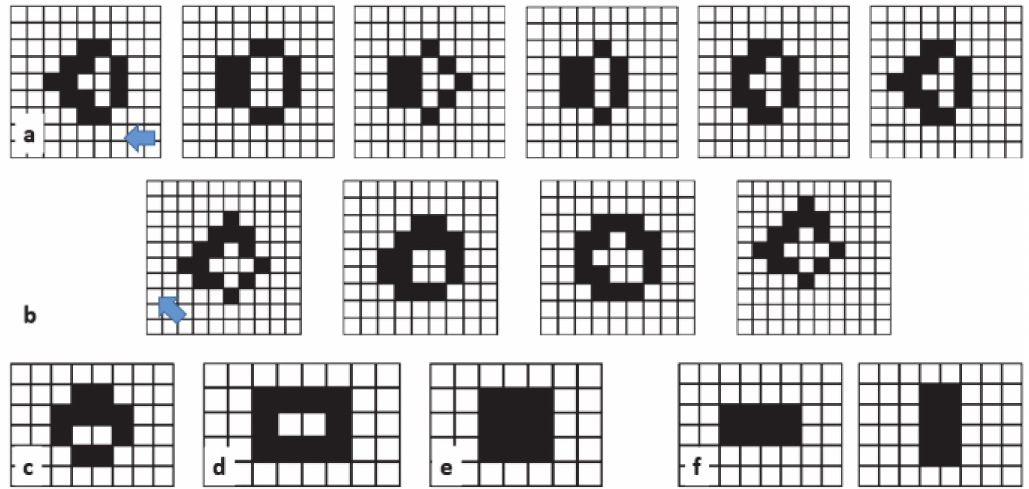
Figure 18. Most common clusters in the equilibrium state of the extended GoL B789/S69. ( a ) Orthogonal glider: Moves a cell forward in 5 steps, parallel or perpendicular to the grid. ( b ) Diagonal glider: Moves a cell in four steps. ( c ), ( d ) and ( e ), three different stable clusters. ( f ) Blinker. Period two.